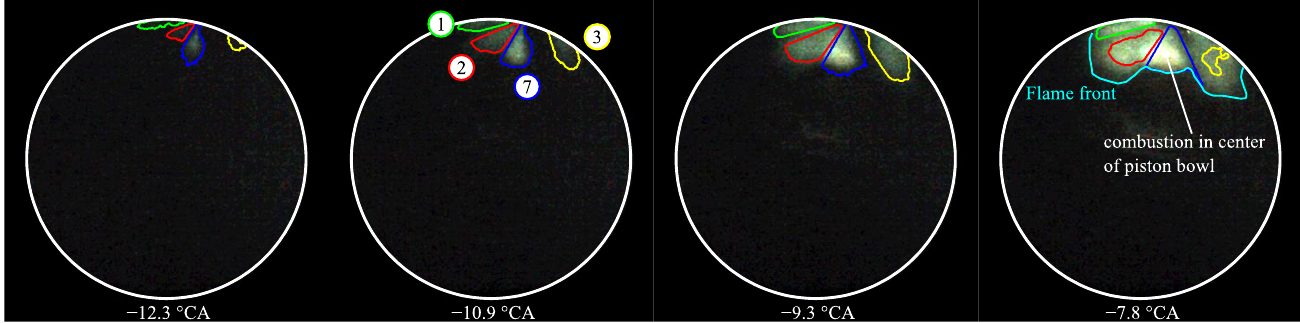
Figure 16. Image series of torch ray of 10HCH 4 at CoC = 8 ◦ CA AFTDC and λ = 1.7 (numbers indicate torch ray).